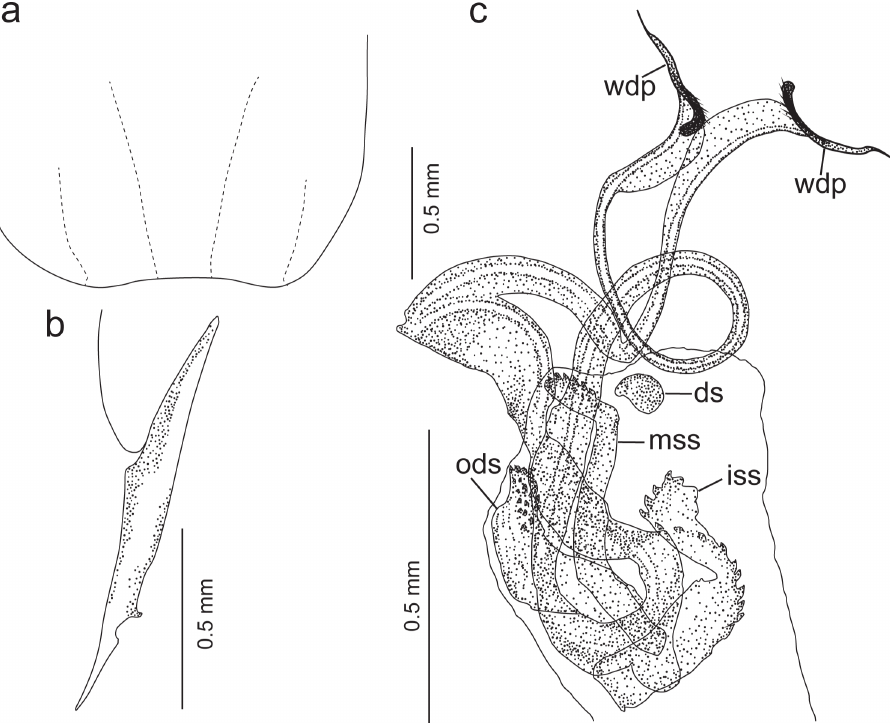
Figure 2. Diplatys sahyadriensis sp. nov. (male holotype) a posterior half of penultimate sternite b left paramere c left penis (in repose), virga with whip-like distal processes (wdp), and associated sclerites (ds, disc-shaped sclerite; iss, inner serrated sclerite; mss, mid serrated sclerite; ods, outer denticulated sclerite). Table 2. Measurements (mm) of the male holotype of Diplatys sahyadriensis sp. nov. Length Measurement